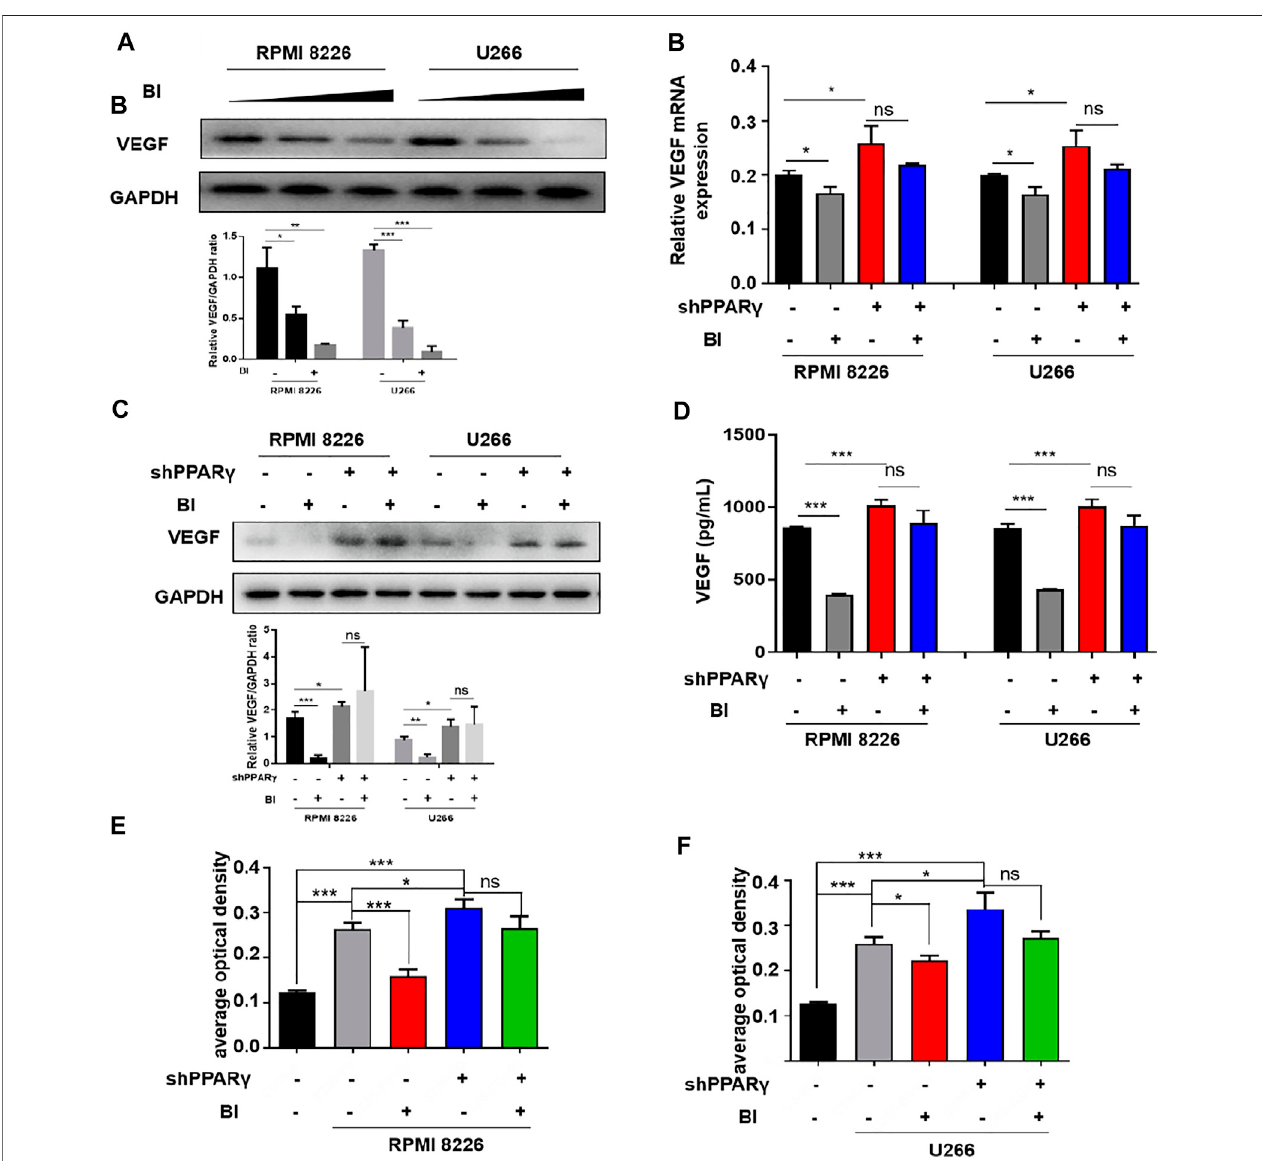
FIGURE 5 | Inhibition of VEGF by BI requires PPAR γ . (A) VEGF expression in MM cells was determined by WB after BI treatment. (B,C) mRNA and protein expression of BI-treated MM cells after PPAR γ knockdown were detected by WB and PCR, respectively. (D) Expression of VEGF in the supernatant of MM cells was detected by ELISA. (E,F) Growth of HUVECs exposed at the MM cell supernatant which was in the presence or absence of BI and PPAR γ knockdown and detected by MTT.